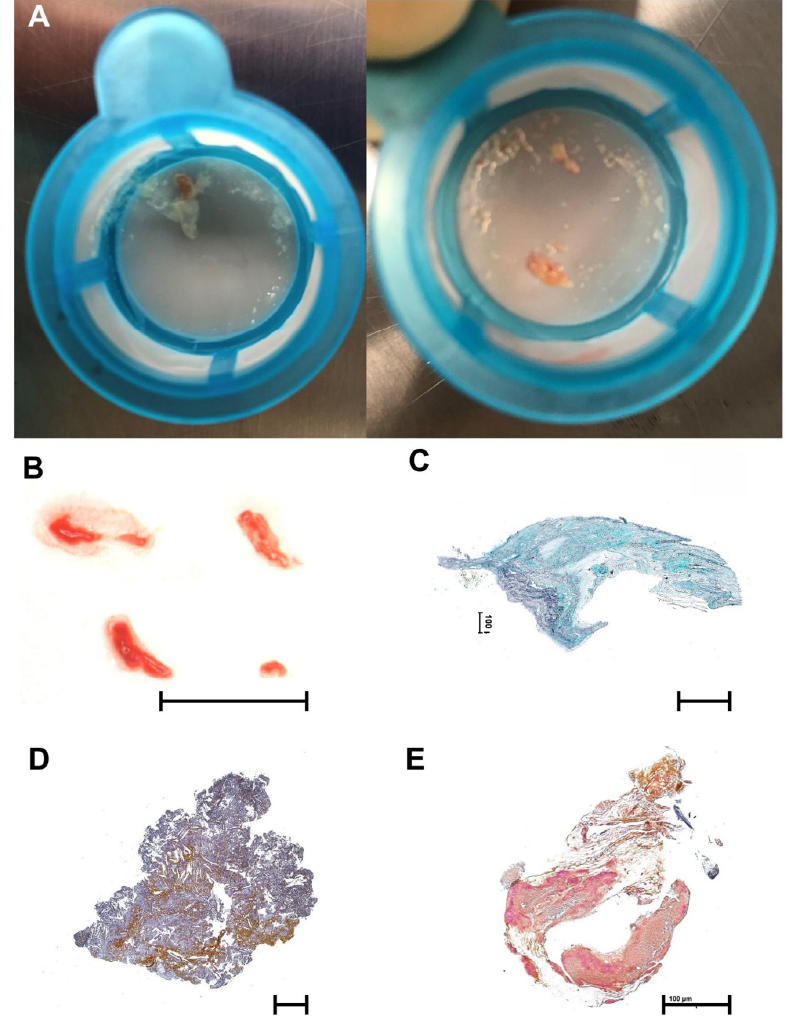
Figure 4. Debris captured in Sentinel™ filters. ( A ) Macroscopic images of fresh debris as collected immediately after the procedure; ( B ) Macroscopic image of fresh debris, black scale bar indicates 5mm; ( C – E ) Tissue stained with trichrome, black scale bar indicates 400µm; ( C ) valve tissue; ( D ) atherosclerotic plaque; ( E ) thrombus and fibrous tissue.